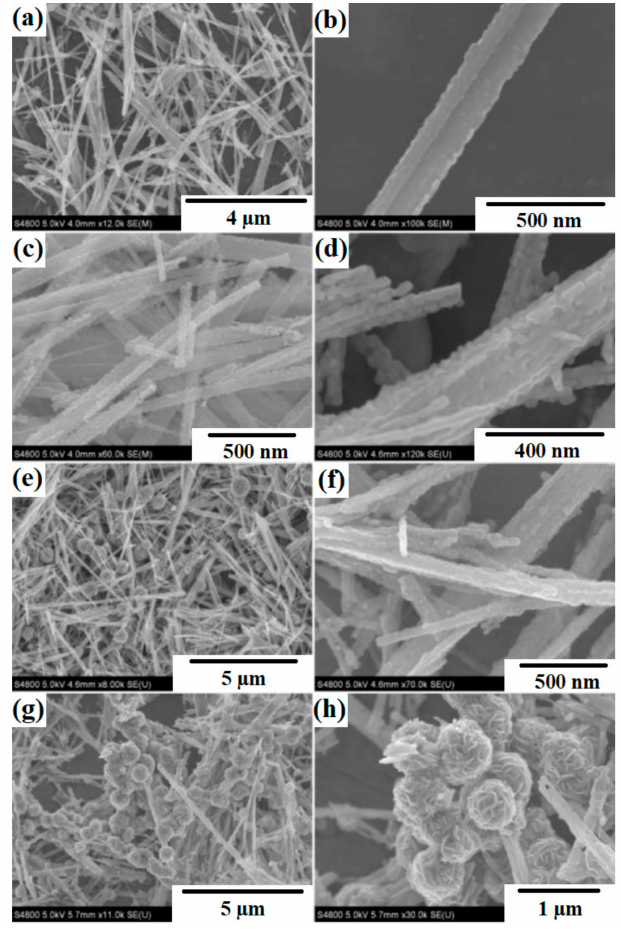
Figure 6. SEM images of TiO 2 -MoS 2 hybrid systems with MoS 2 contents of ( a , b ) 20%; ( c , d ) 40%; ( e , f ) 60%; and ( g , h ) 80% (created based on [98] with permission from Elsevier